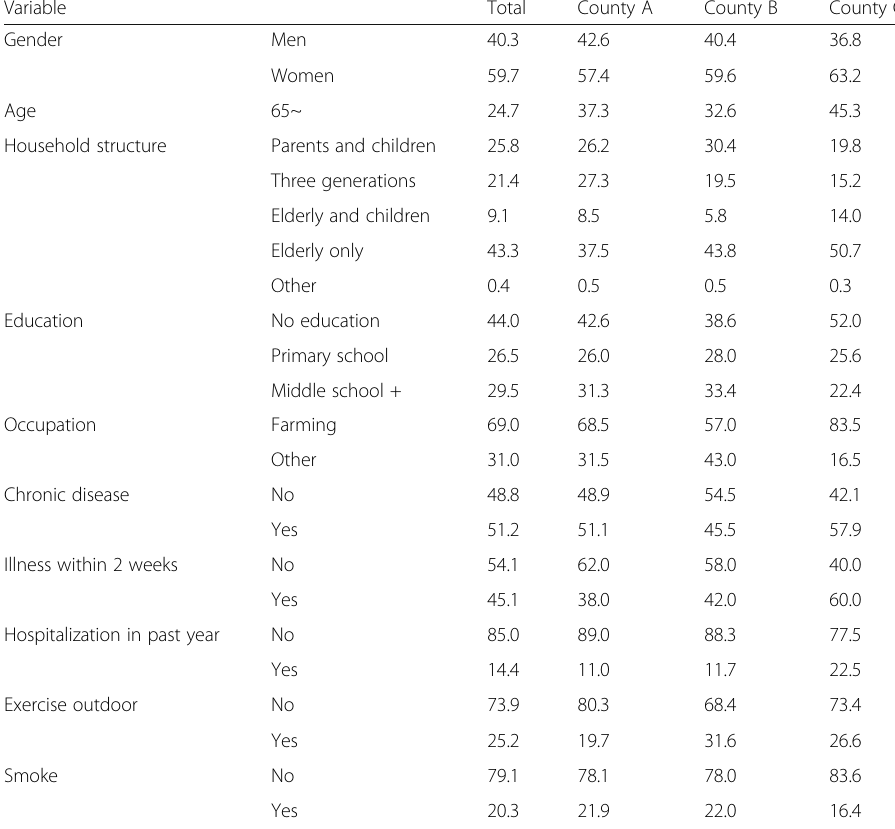
Table 2 Descriptive characteristics of respondents in different counties (%) Variable